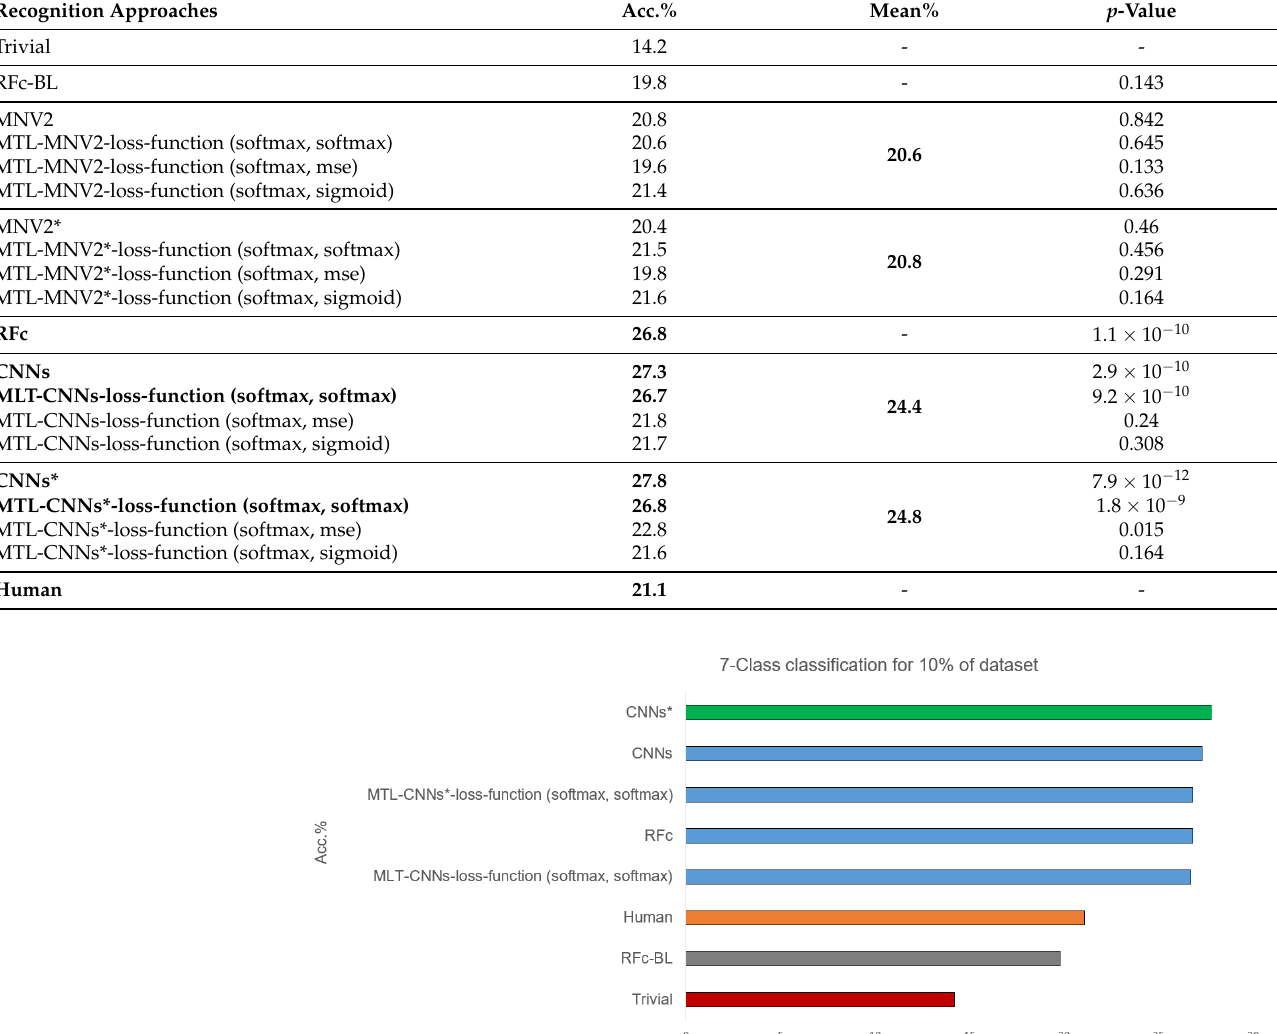
Table 3. Recognition approaches accuracy results of phasic stimuli 7-class classification task for 10% of dataset, the meaning of abbreviations is provided by the list in abbreviations section.